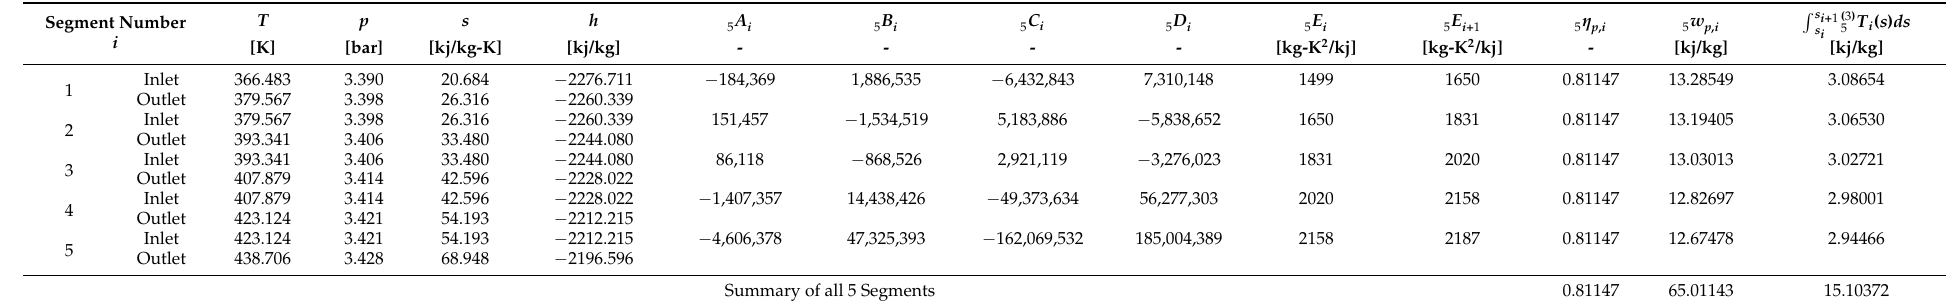
Table 1. Cubic polynomial 5-segment method as applied for Case 10 using AspenTech Hysys V.10 [27] and PR-LK equation of state. See Table A1 in the Appendix B for gas compositions and compressor inlet and discharge conditions for Case